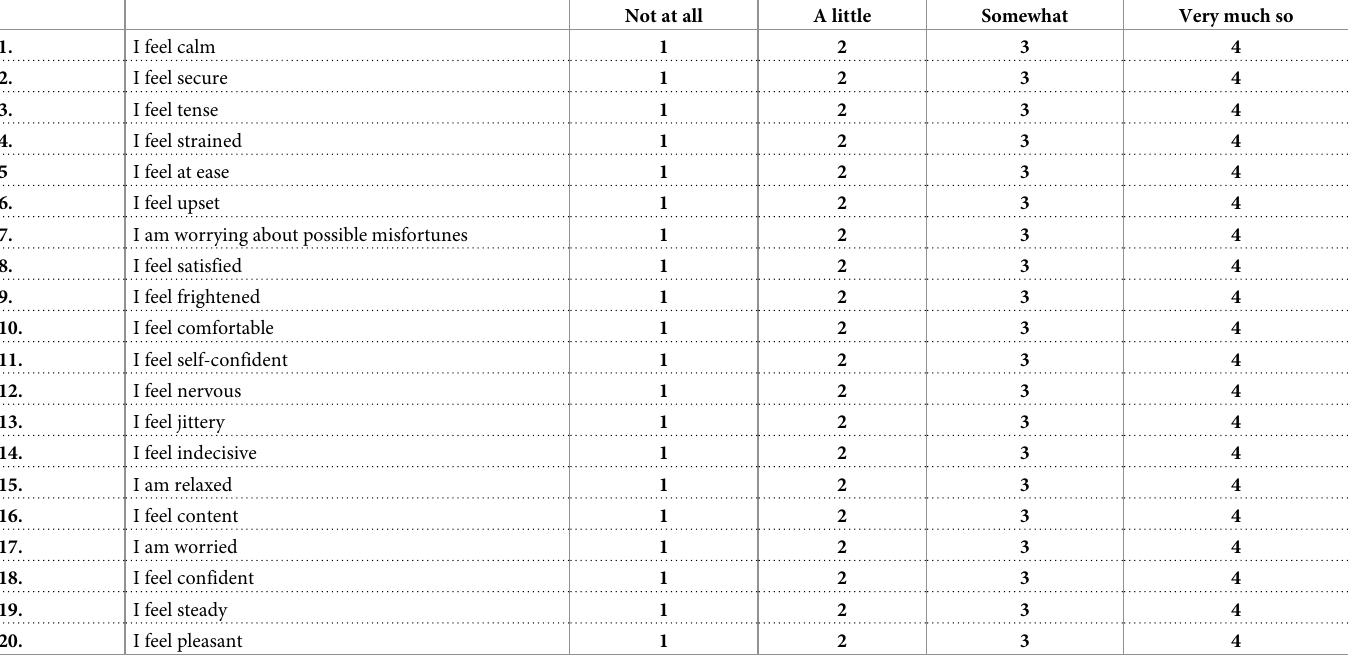
Table 1. Anxiety scale used before and after the endovascular intervention.